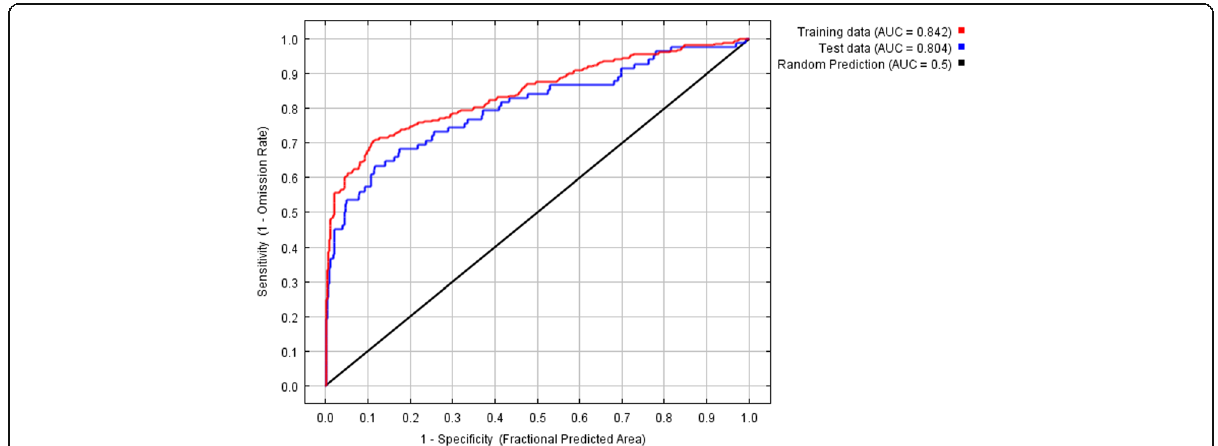
Fig. 2 Sensitivity versus specificity graphs for VL disease distribution using the final ENM